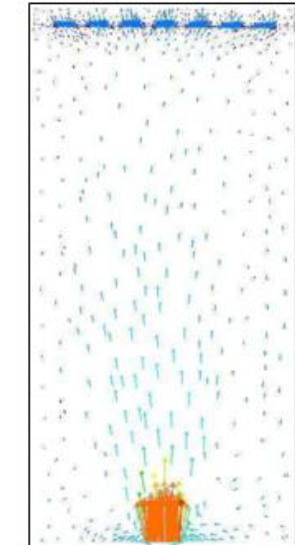
Figure 6. Fluid flow contour in sub-channel with cylindrical square array for forced convection.